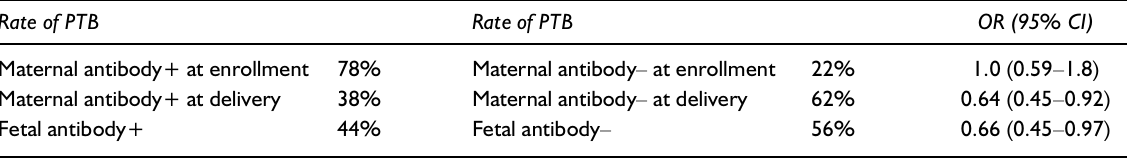
Table 1 Rates of preterm birth (PTB) correlated with antibody